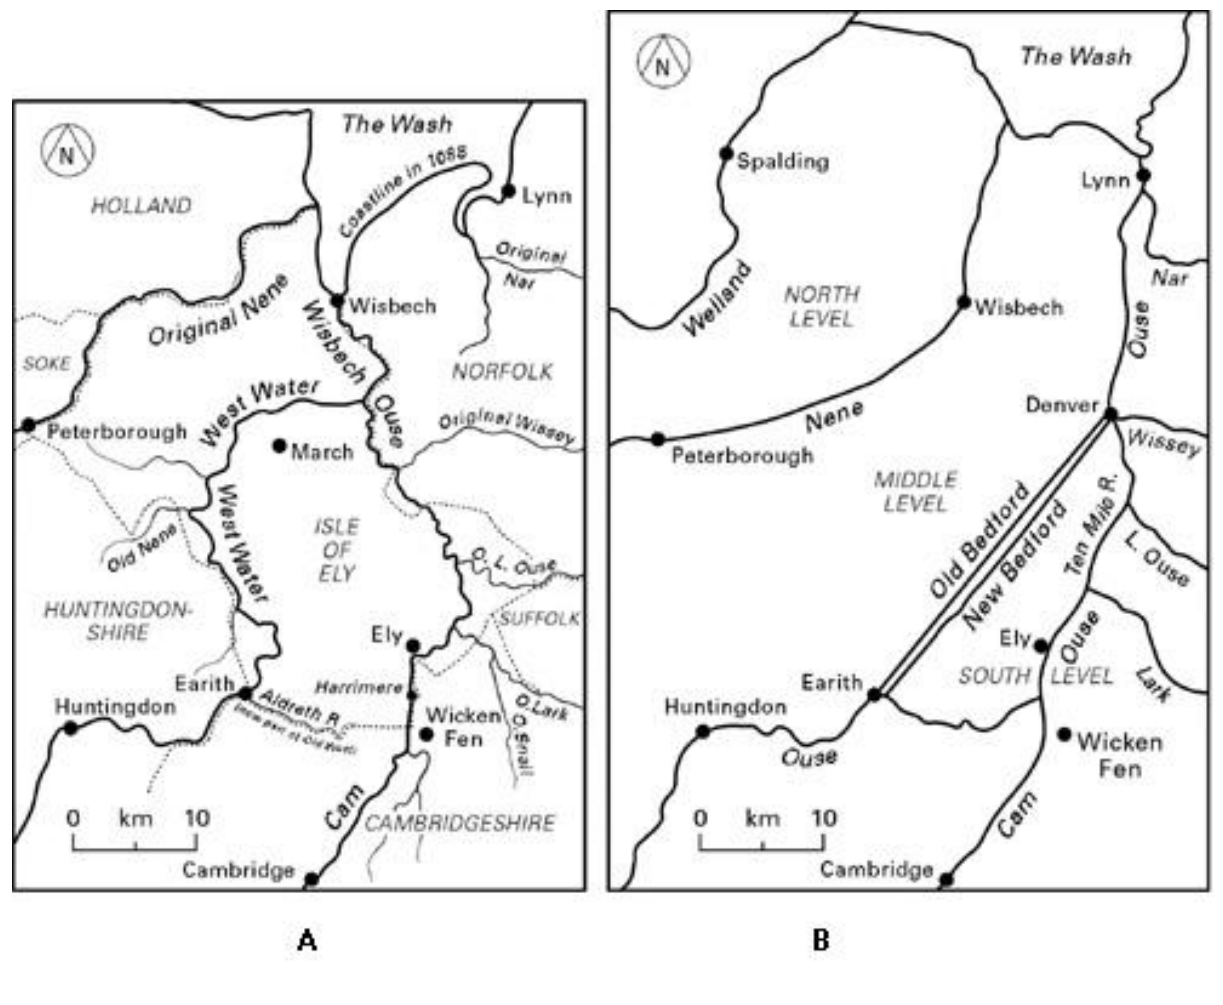
Fig. 7. The four main rivers of pre-Roman Fenland drained northwards into The Wash. The coastline was considerably inland of the present-day coastline (A). During the 17th century, the rivers were realigned, and an extensive drainage system was dug (B). Today the abandoned river channels remain in the form of sinuous gravel ridges, 2–3 m above the level of the land (after Astbury